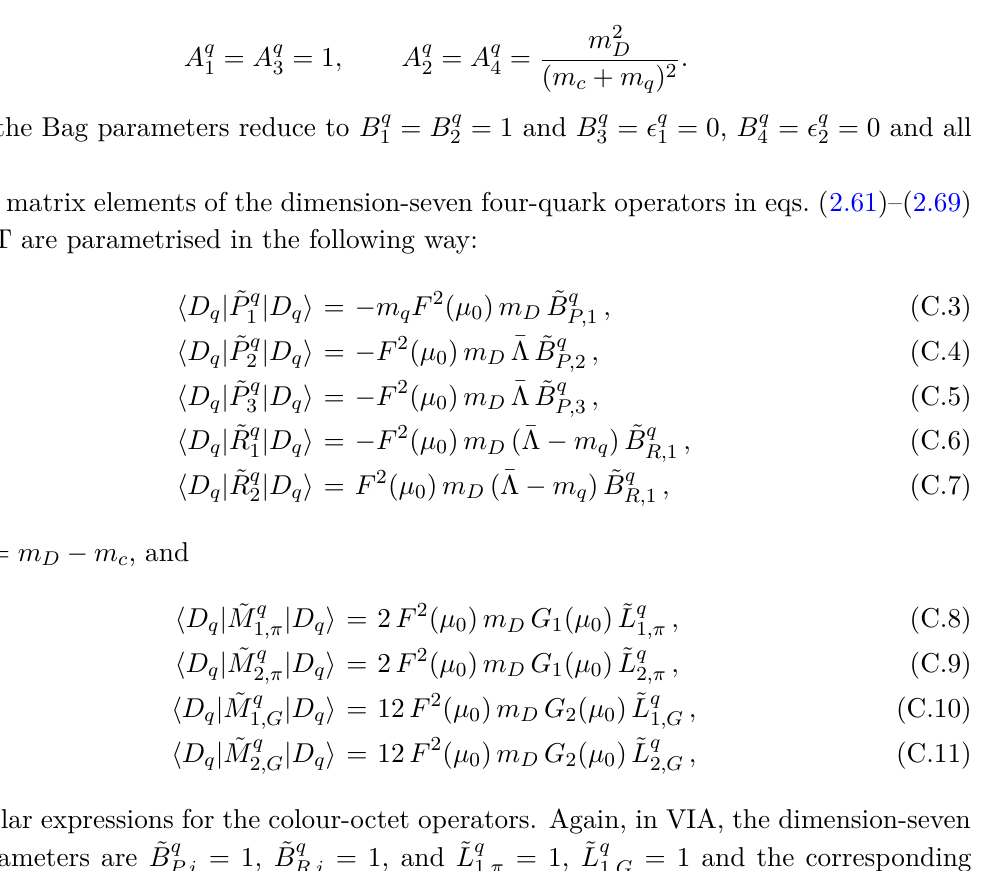
Table 18 . Numerical values of C ( q 1 q 2 ) ρ